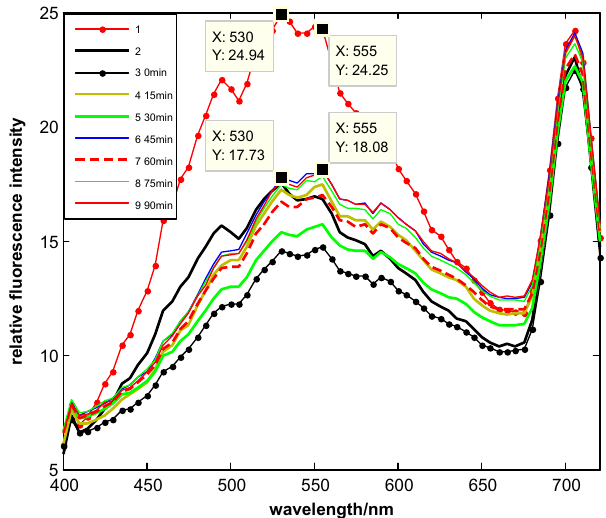
Fig. 2. Comparing of °uorescence spectrum curves at di®erent decocting time.